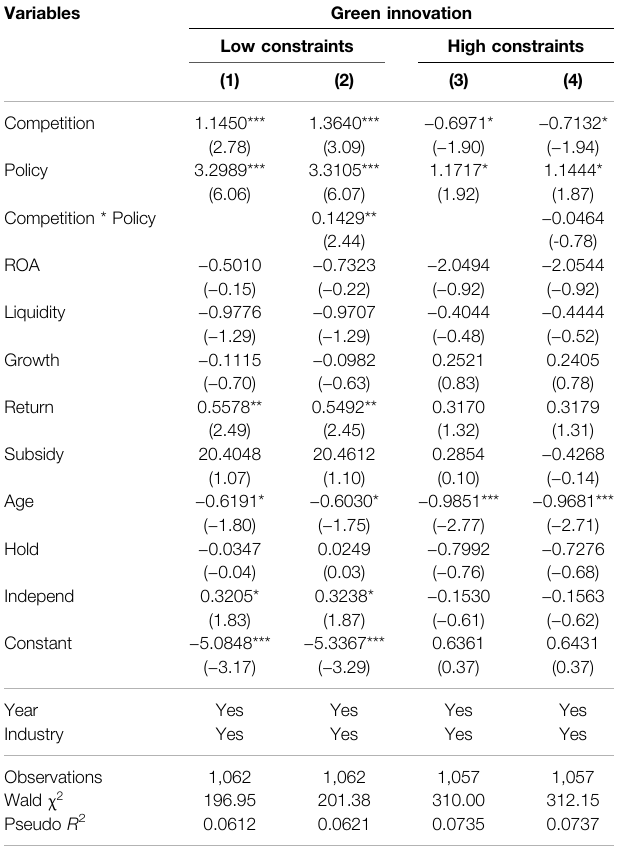
TABLE 5 | Results of different fi nancial